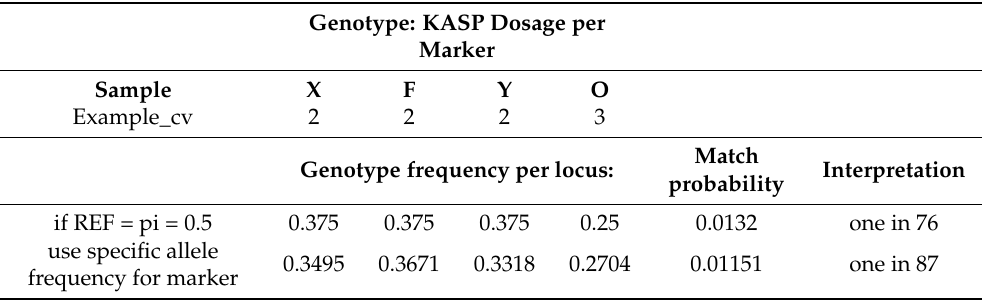
Table 2. A calculation of the random match probability of a query sample after genotyping with a small number of SNP markers. This calculation illustrates the difference between using REF as 0.5 or as the genotype allele frequency as determined for 190 potato